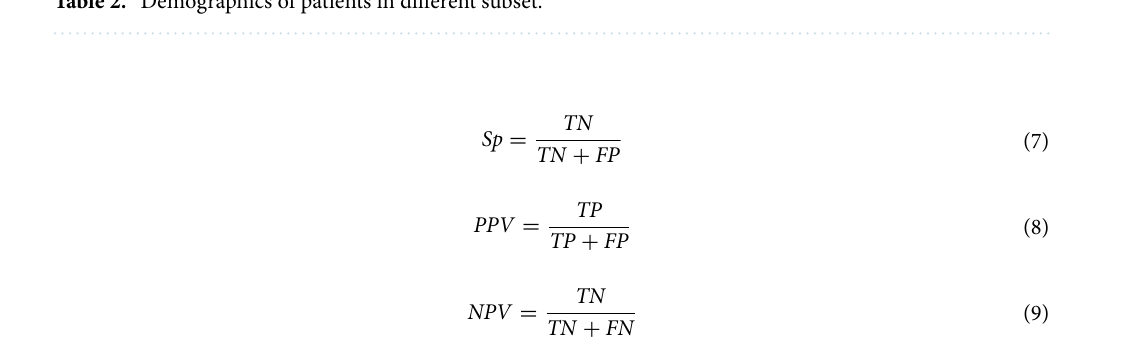
Table 2. Demographics of patients in different